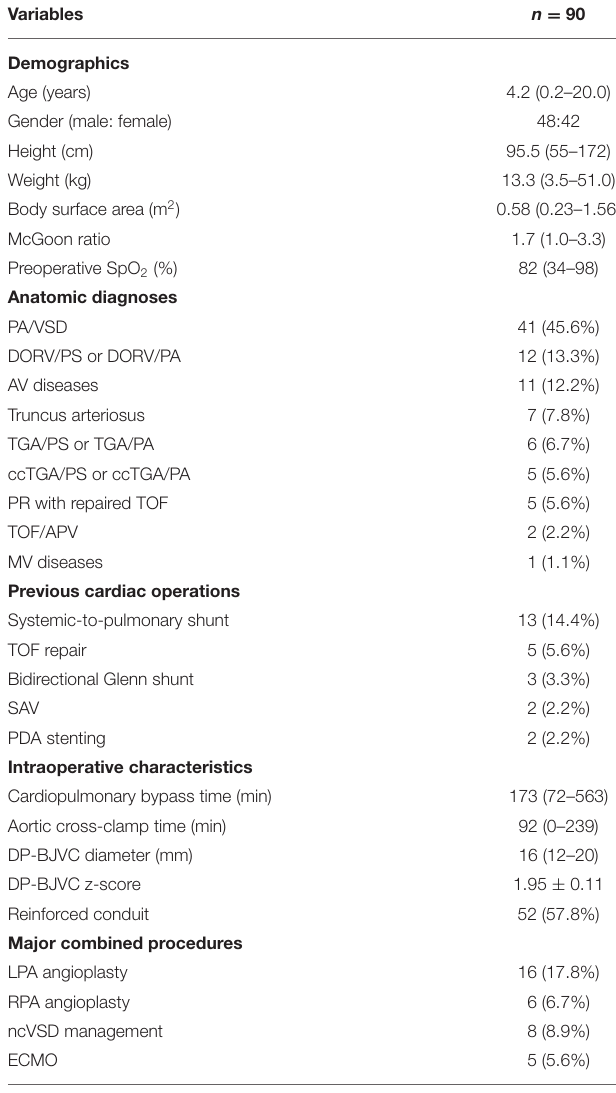
TABLE 1 | Demographic and operative data of the cohort using DP-BJVC.